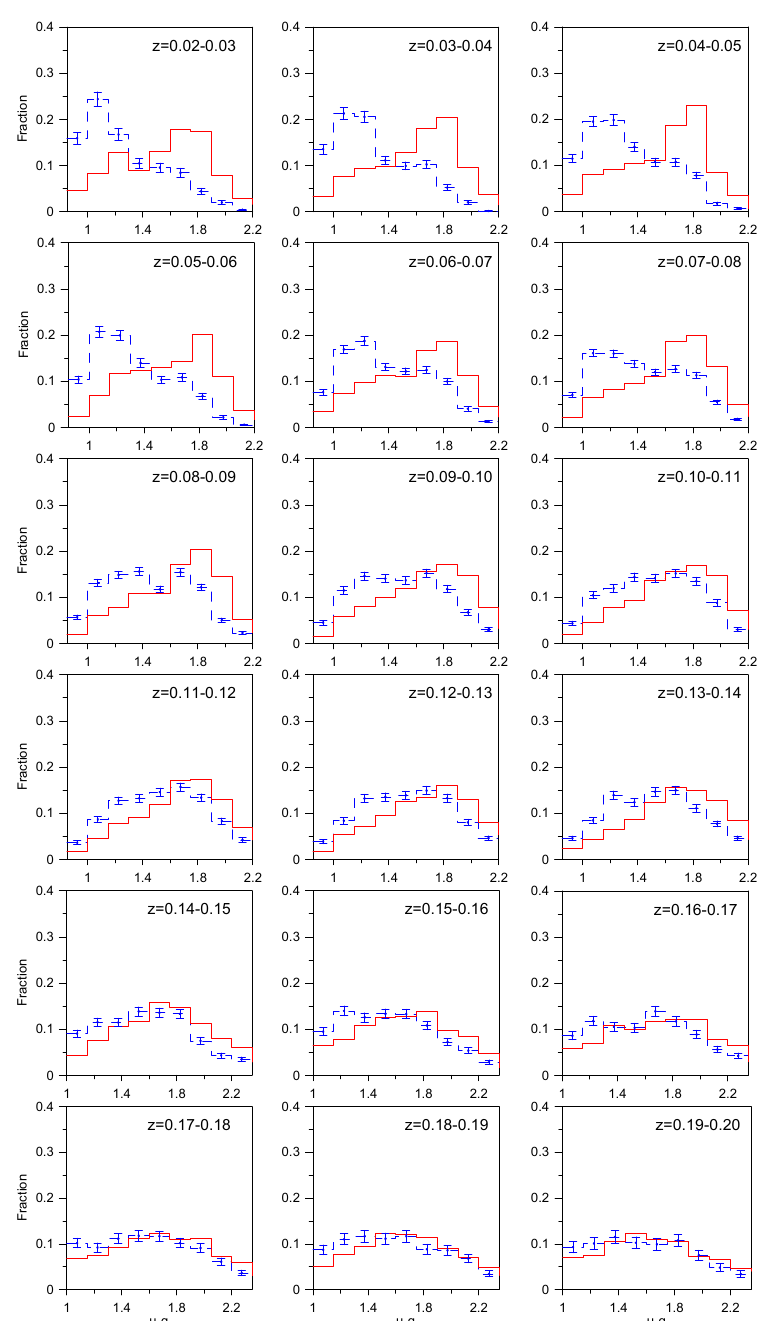
Fig. 2. Distribution of u – g colors. Designations are the same as in Figure